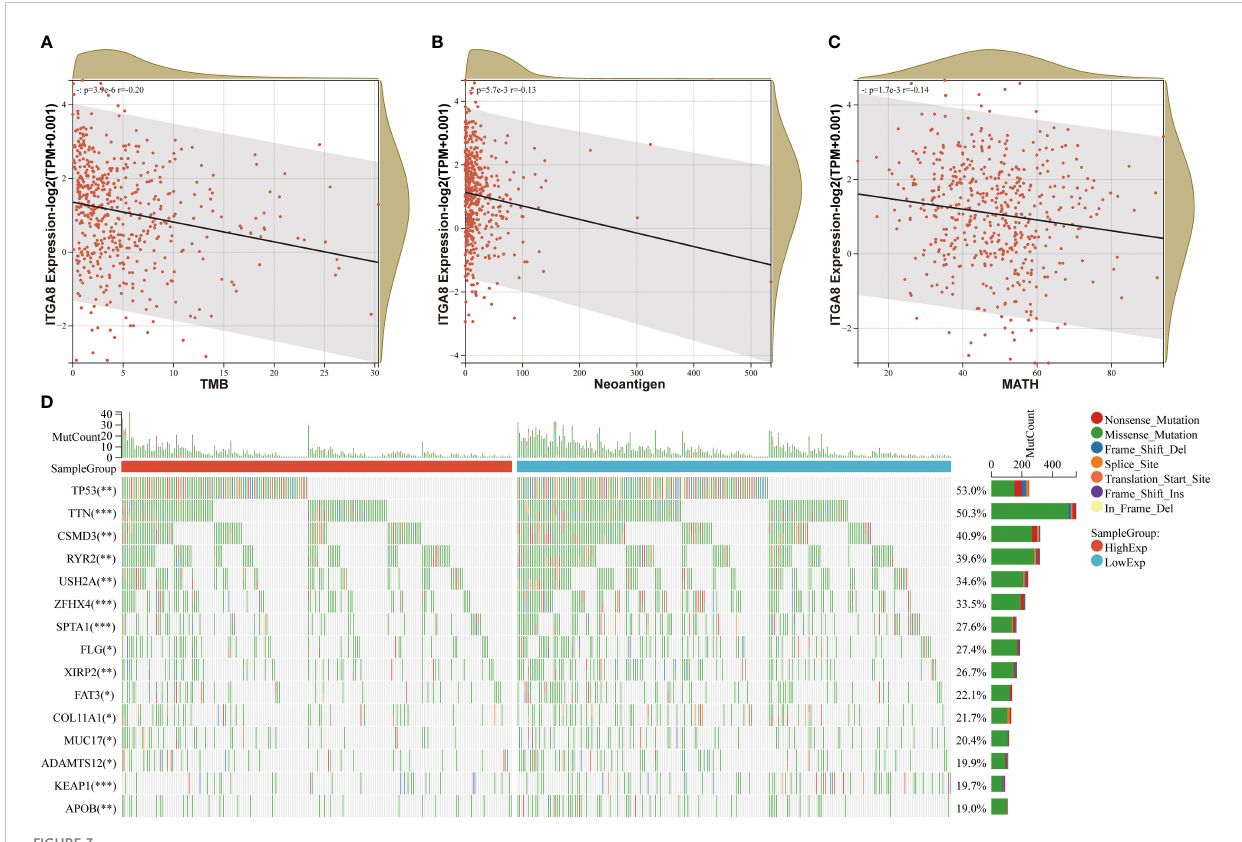
FIGURE 3 Correlation analyses between ITGA8 and TMB, neoantigen, and MATH. (A) Correlation analysis between the expression of ITGA8 and TMB in LUAD samples ( r = − 0.20, p < 0.001). (B) Correlation analysis between the expression of ITGA8 and neoantigen in LUAD samples ( r = − 0.13, p = 0.0057). (C) Correlation analysis between the expression of ITGA8 and MATH in LUAD samples ( r = − 0.14, p = 0.0017). (D) Mutation landscape map for the high and low expression groups of ITGA8 in patients with lung adenocarcinoma. * p < 0.05, ** p < 0.01, *** p < 0.001. The expression level of ITGA8 gene was marked as Log 2(TPM +0.001)